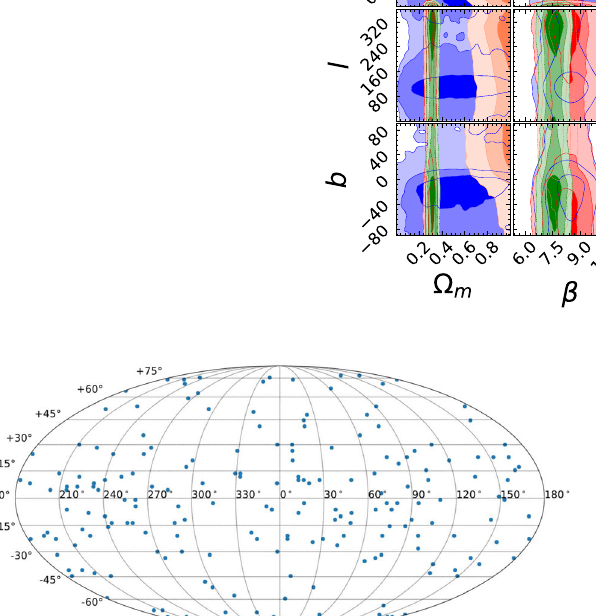
Fig. 6. Most of the preferred directions derived from dif- ferent samples are located in a relatively small part of the south galactic hemisphere and they are consistent within